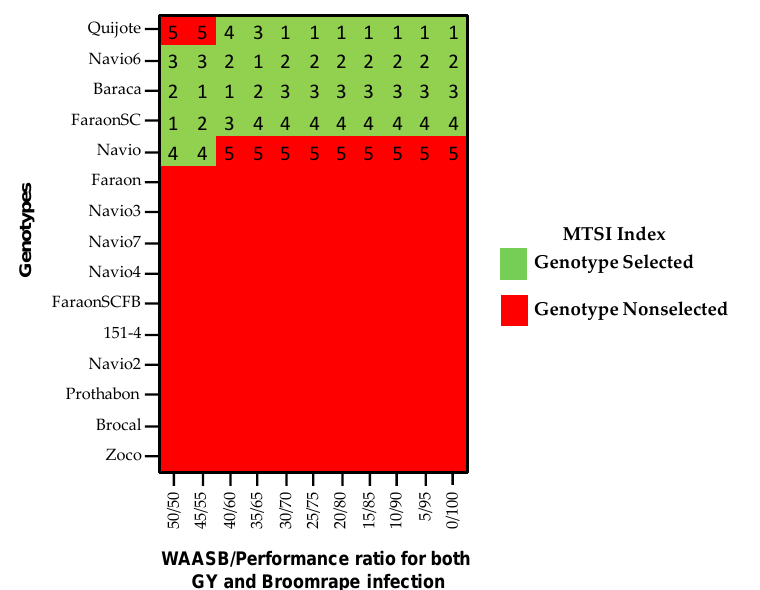
Figure 5. Heatmap showing the first five of the MTSI index rank of 15 faba bean genotypes considering different weights for stability and both the GY and number of broomrape per plant.